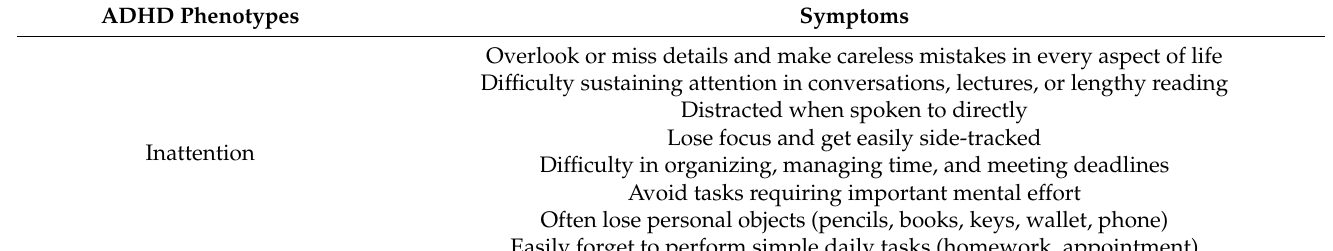
Table 2. ADHD phenotypes and their components. The main symptoms observed in ADHD indi- viduals are presented depending on ADHD phenotypes.